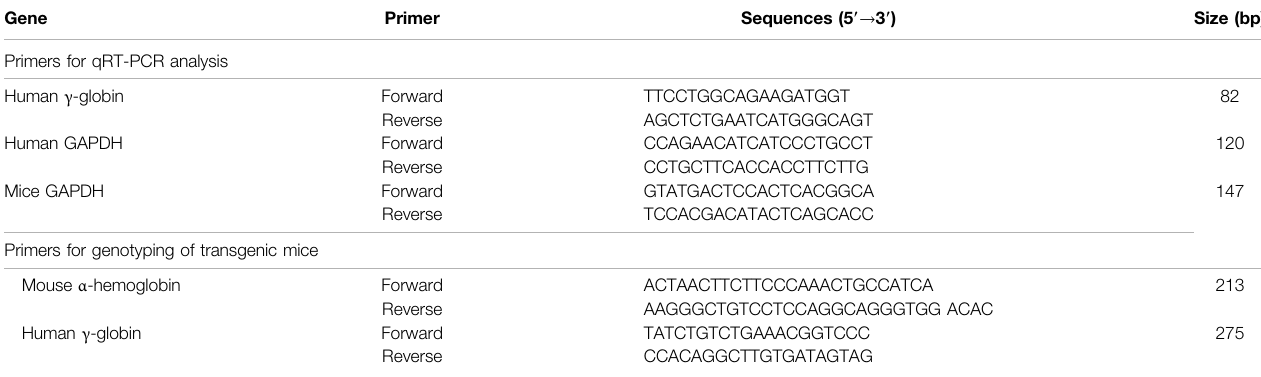
TABLE 1 | Sequences of primers used in qRT-PCR analysis and genotyping of transgenic